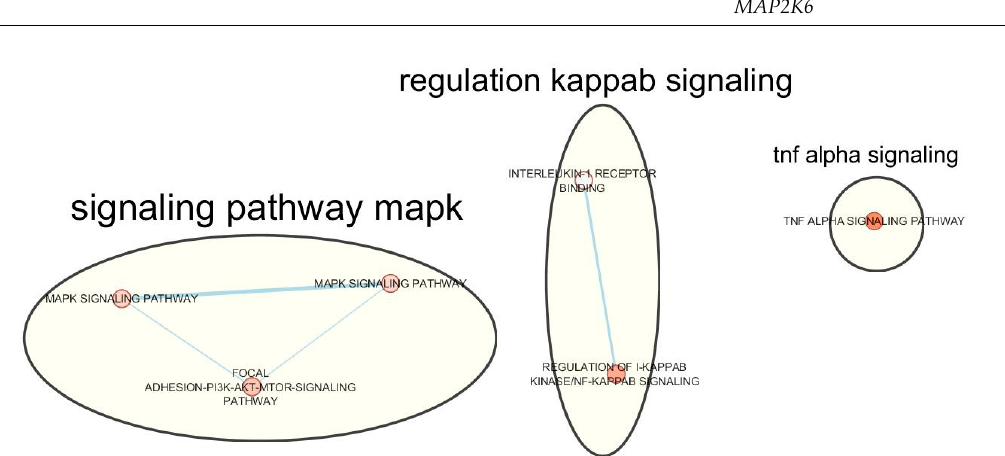
Figure 1. Clustered biological themes for overlapping endometriosis–migraine genes.